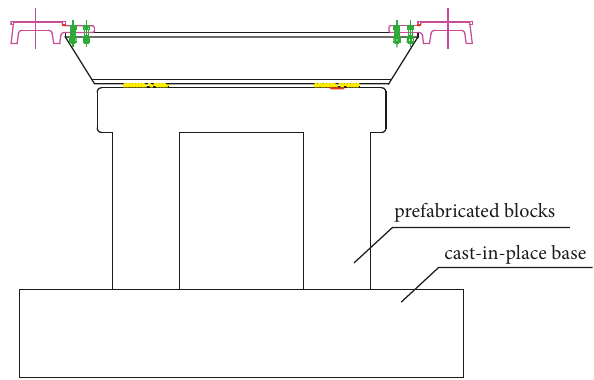
Figure 5: Cross-sectional diagram of the track and rail bearing